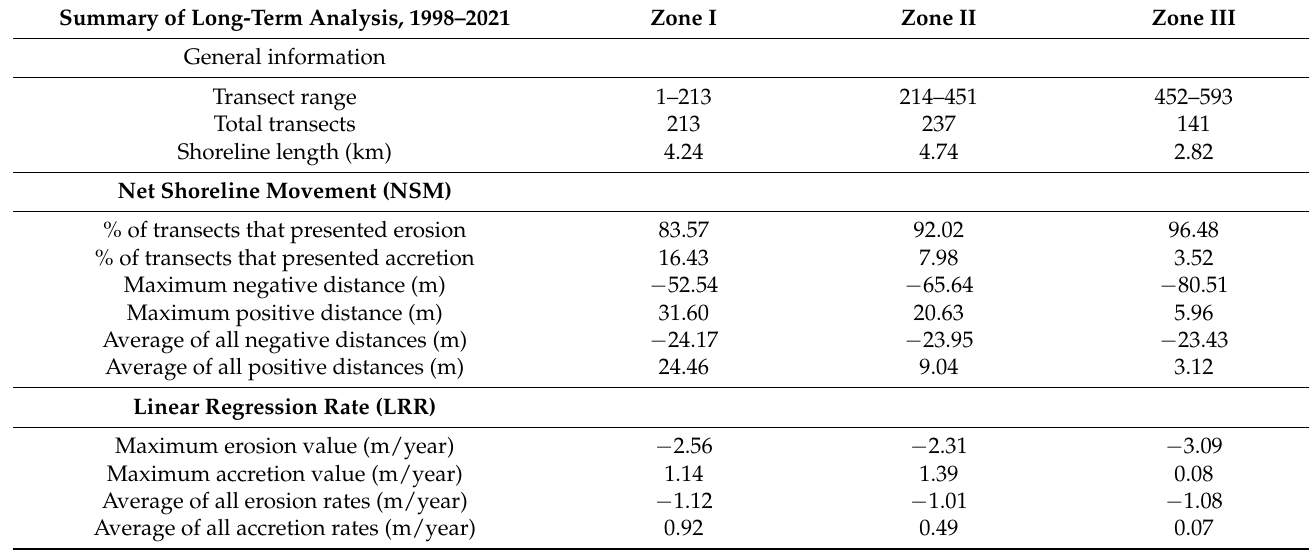
Table 6. Summary of the results obtained for the long-term analysis.